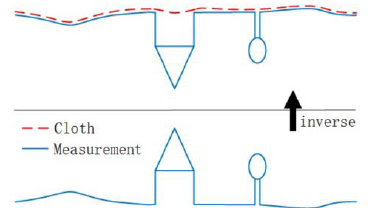
Figure 3. Overview of the cloth simulation algorithm (Zhang et al. 2016)